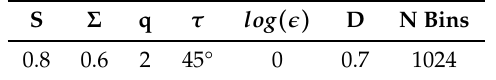
Table 1. Calibration parameters of the Line Segment Detector, as presented in [29].